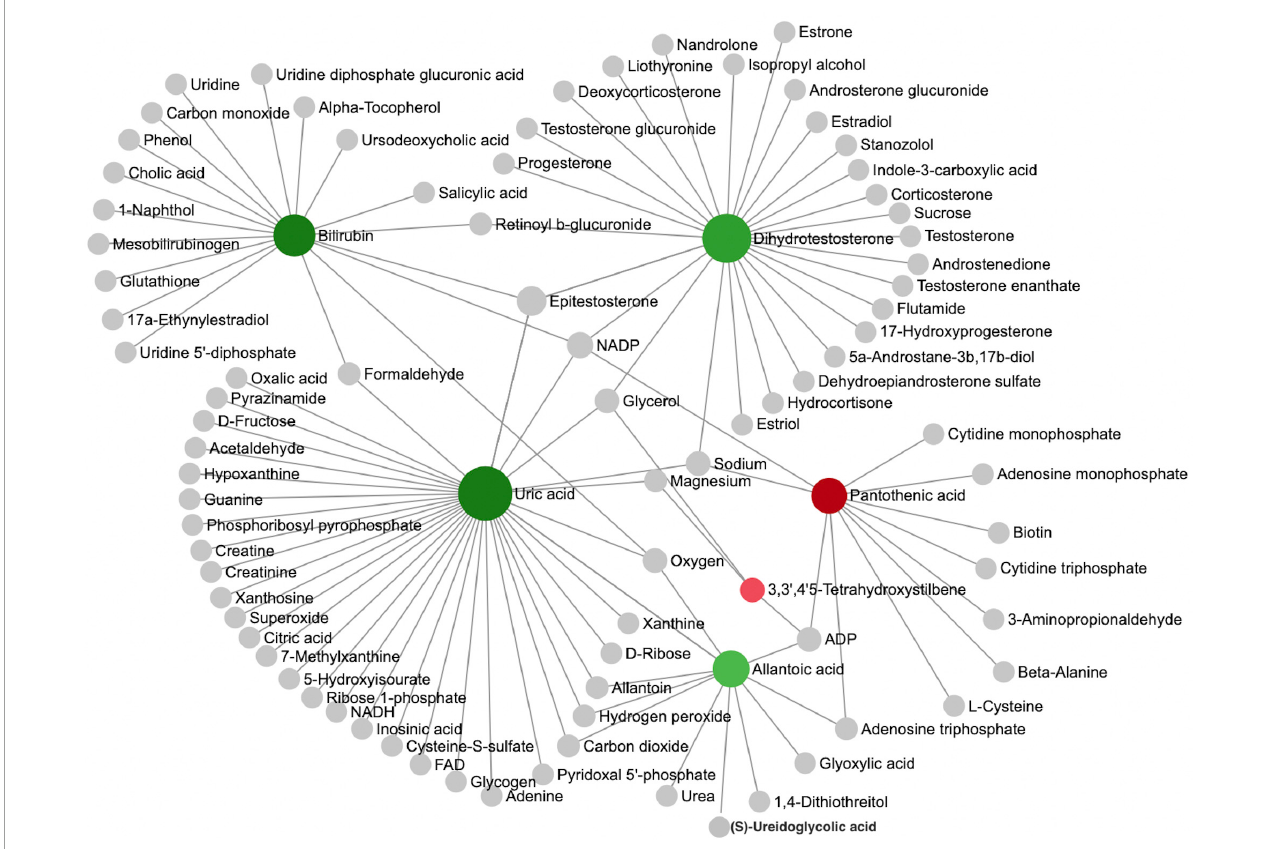
FIGURE2 Analysis of metabolic networks between significantly different metabolites. The chemical-chemical associations of the metabolite networks were extracted from STITCH (http://stitch.embl.de/), using only highly confident interactions. In graph networks, nodes with a higher number of connections to other nodes are more important and have larger node sizes, and they act as hubs in the network. The colors represent the direction of change of ASD relative to the TD group: green nodes indicate a decrease, and red nodes indicate an increase. The metabolites represented by the gray nodes are not included in the results found in this study but are based on metabolites associated with similar chemical structures and similar molecular activities.